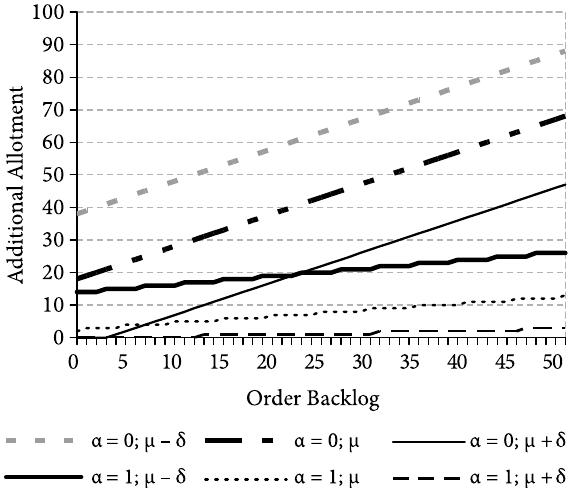
Fig. 3. Optimal additional allotment for given backlog for discrete uniform demand and backlog cost 3 B